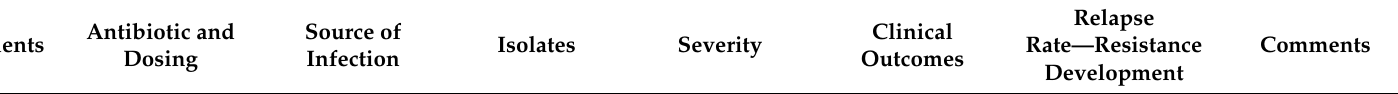
Table 1. Summary of studies investigating the treatment of different types of infection caused by methicillin-susceptible Staphylococcus aureus with oxacillin or